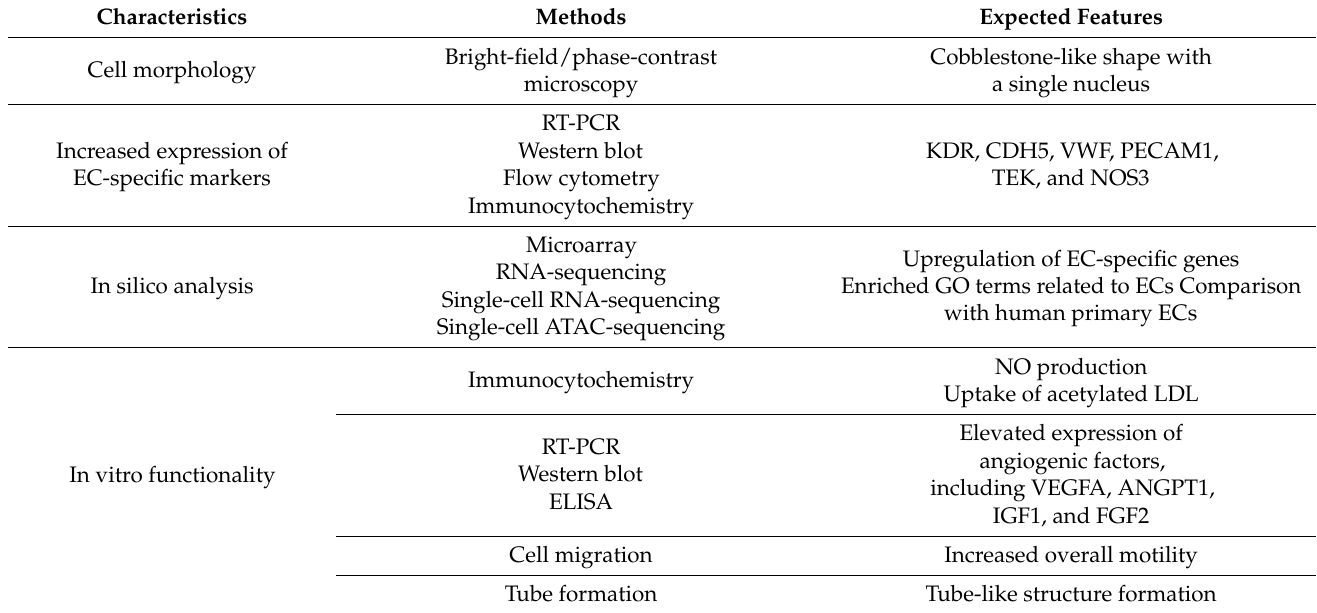
Table 1. Criteria to define the EC